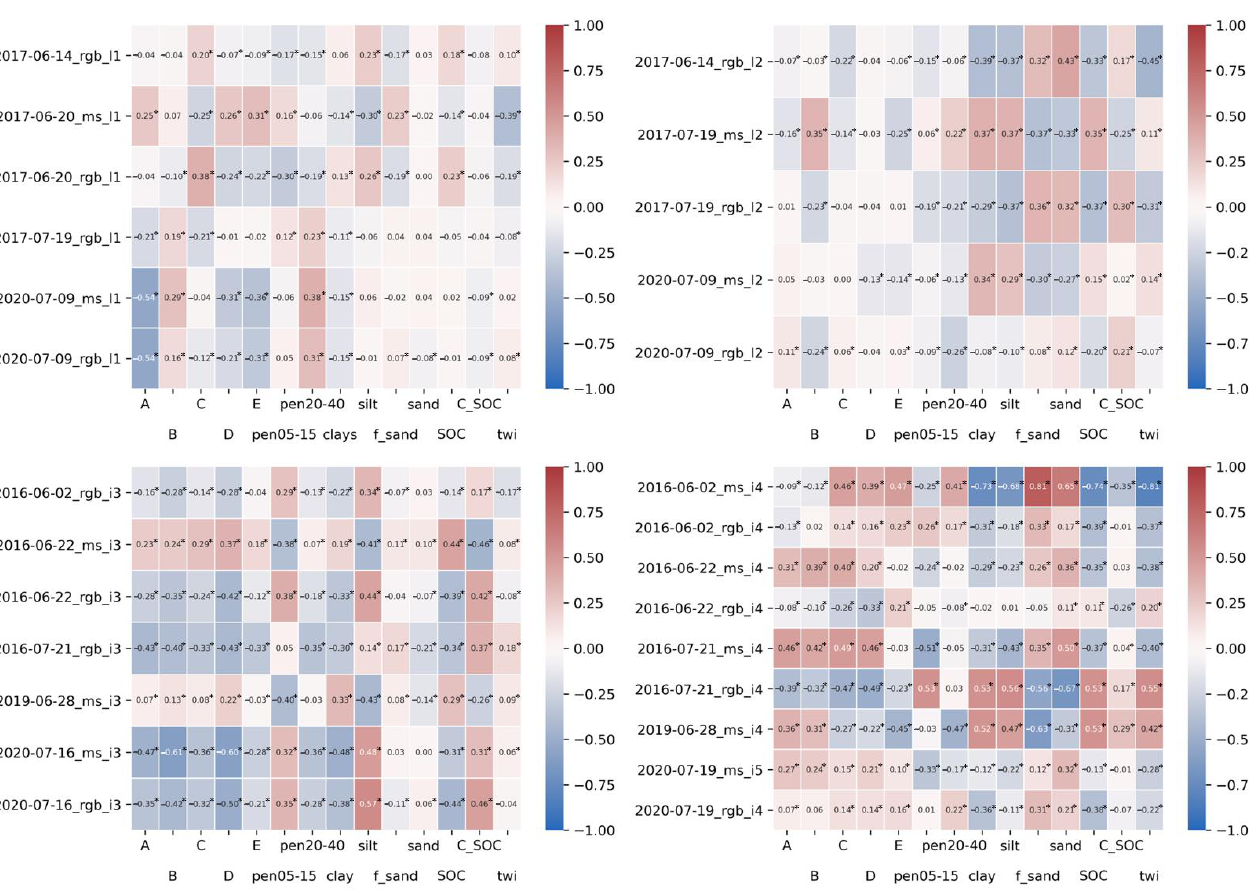
Figure 5. The correlation coefficients between drone datasets and soil properties for all datasets collected in experimental fields l1, l2, i3, and i4. * indicates that the correlation was significant based on the Wald Test with t-distribution ( p < 0.05). A = topsoil biological indicators, B = subsoil macroporosity, C = compacted layers in soil profile, D = topsoil structure, E = subsoil structure, pen05–15 = mean soil penetration resistance in the 5–15 cm layer, and pen20–40 = in the 20–40 cm layer, SOC = soil organic carbon content, C_SOC = clay/soil organic carbon ratio in the 0–20 cm